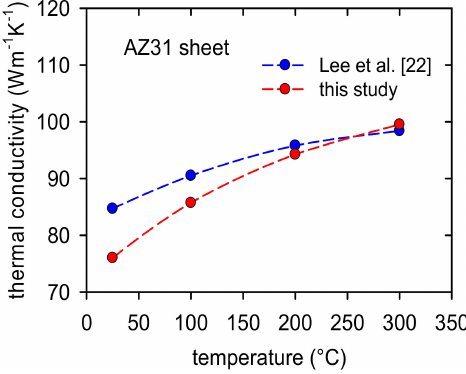
Figure 7. Thermal conductivity of rolled sheets.